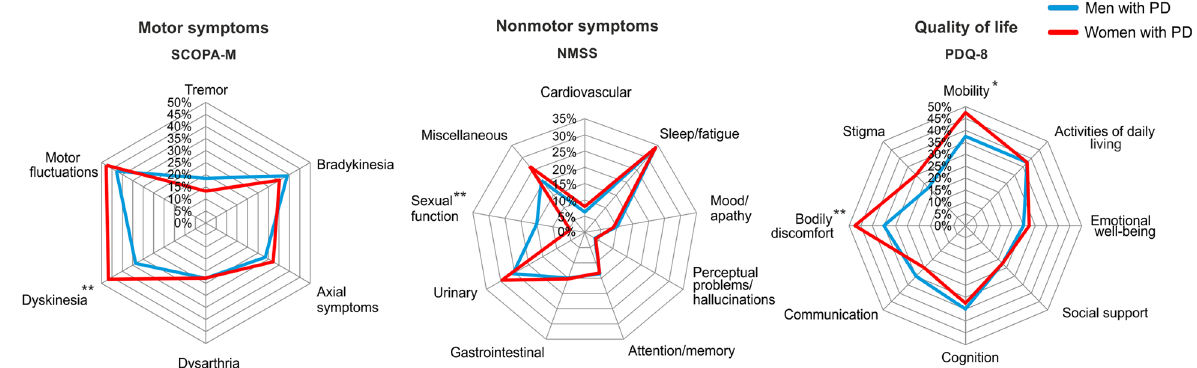
Fig. 2 Preoperative gender differences in the original longitudinal cohort. Figure 2 illustrates motor (left), nonmotor (middle), and quality of life (right) domains in women and men with Parkinson ’ s disease undergoing bilateral deep brain stimulation. NMSS Non-motor Symptom Scale, PD Parkinson ’ s disease, PDQ-8 Parkinson ’ s Disease Questionnaire-8, SCOPA-M Scales for Outcomes in Parkinson ’ s Disease-motor scale. Signi fi cant differences between women and men at preoperative baseline highlighted with: * for P < 0.05. ** for P <